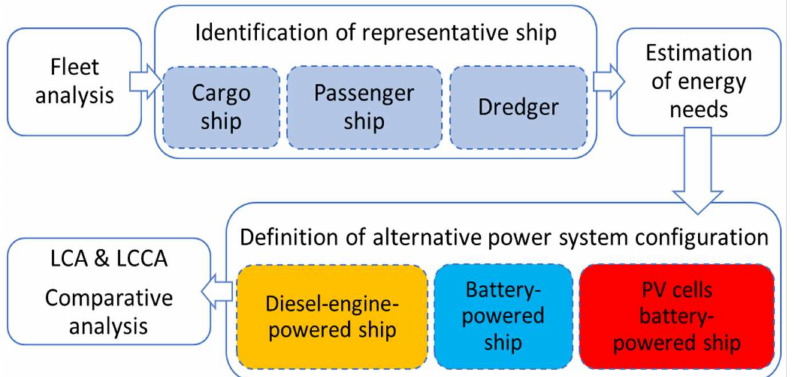
Figure 8. Procedure for the definition of the ship power system of the Croatian inland waterway fleet.